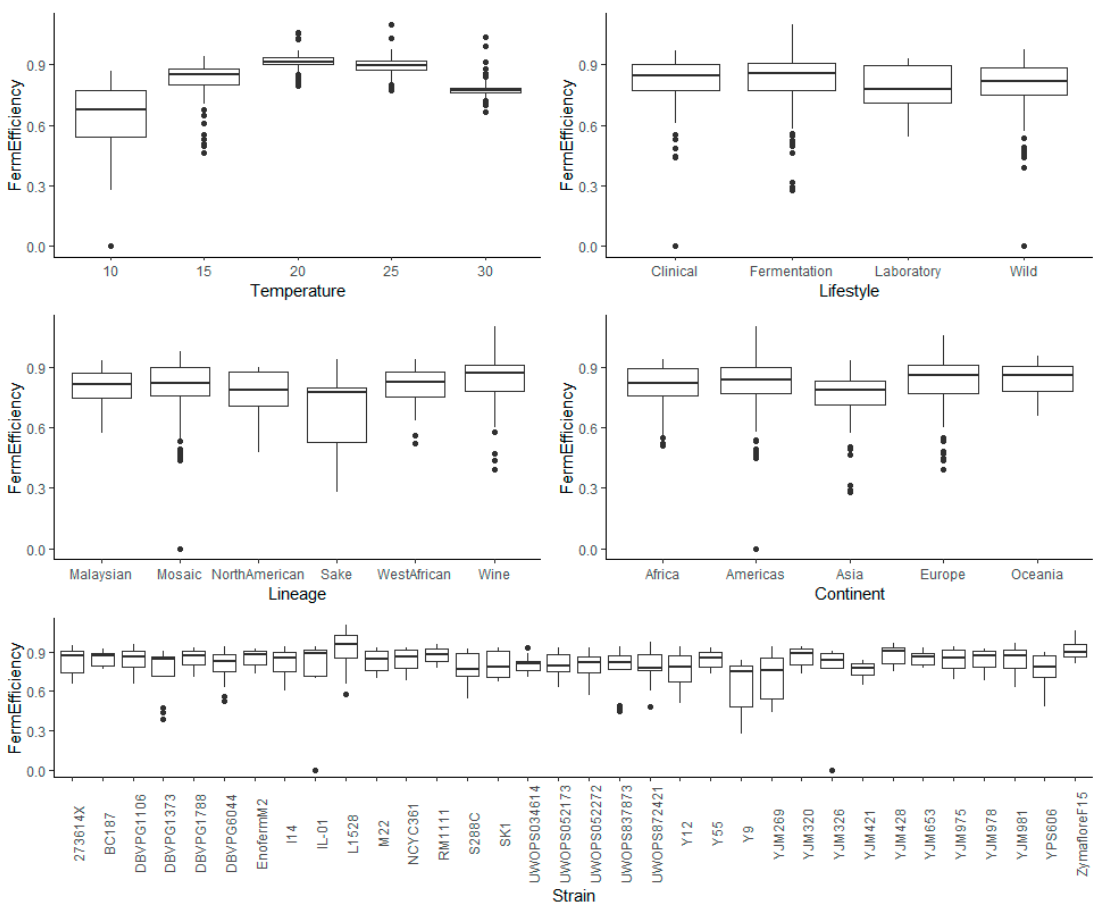
Figure 7. Box plots exploring the relationships between the fermentation efficiency and each of the factors explored in this investigation (temperature, lifestyle, lineage, continent, and strain).